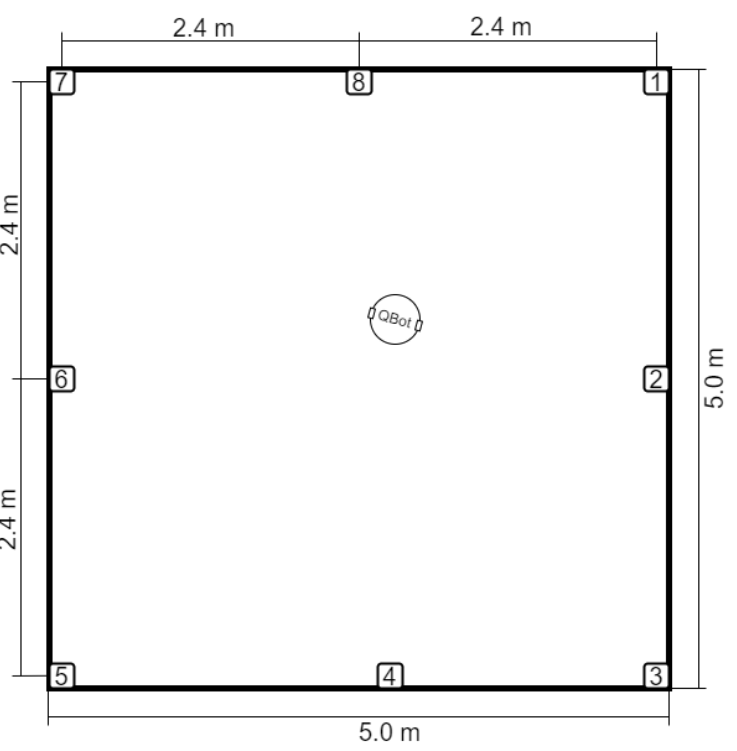
Figure 1. Dimensions of workspace with the arrangement of